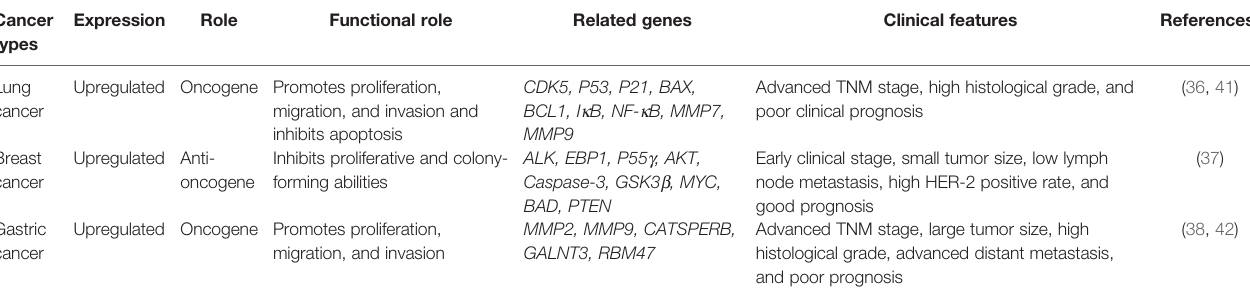
TABLE 1 | Functional characteristics and clinical features of TC2N in human